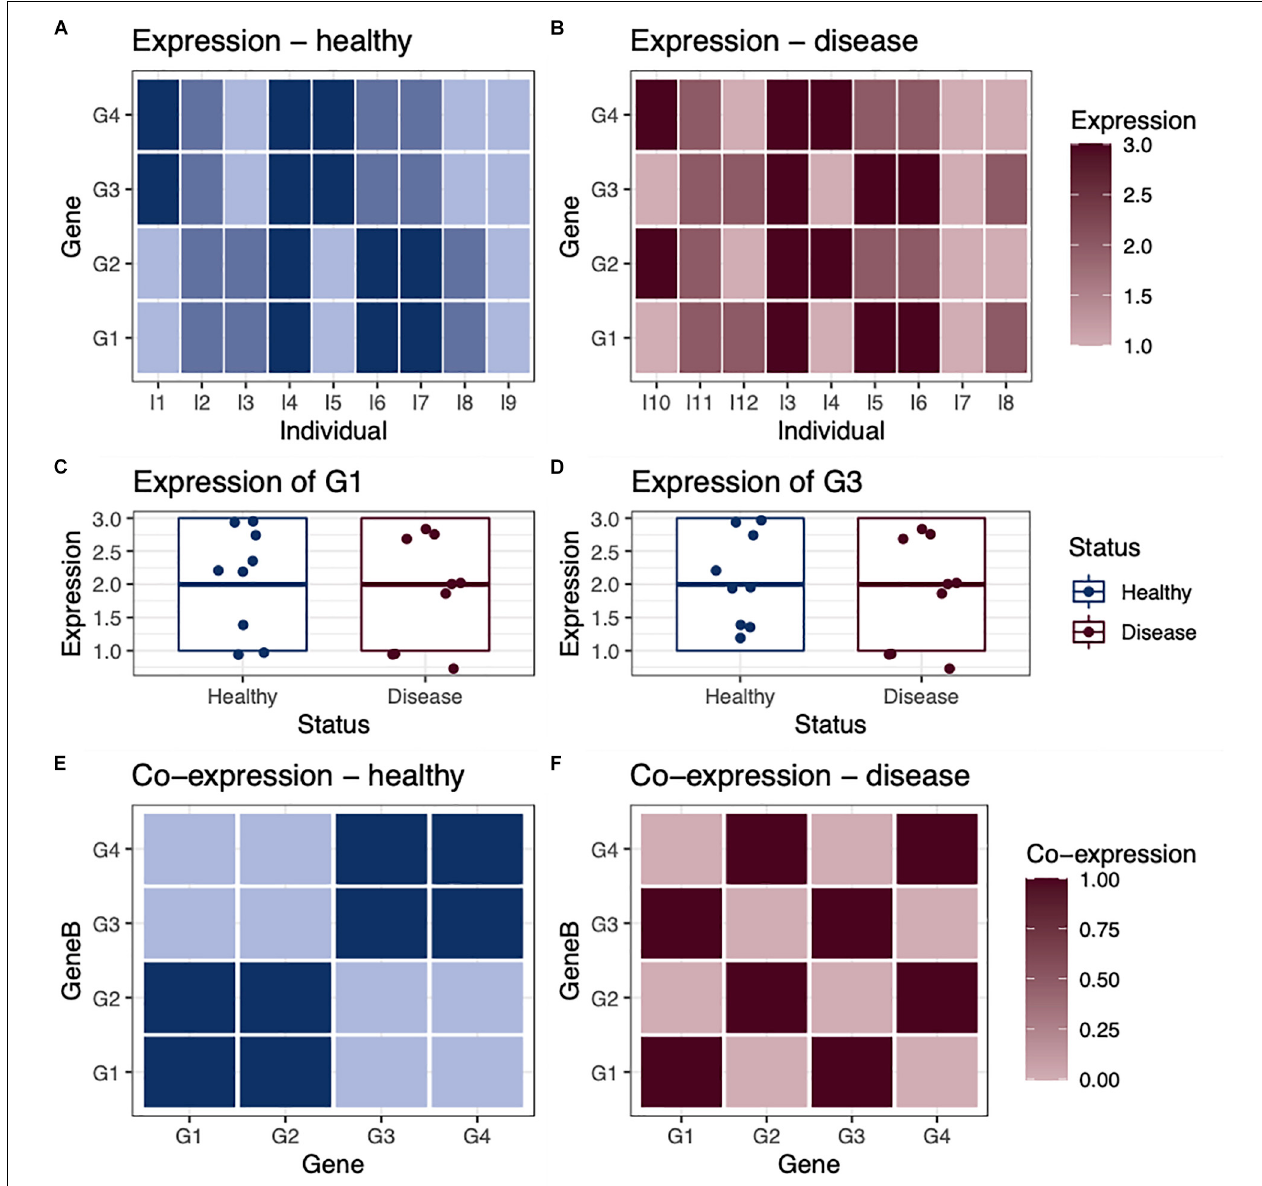
FIGURE 1 | Differential expression vs. differential co-expression. As a toy example, we consider the expression of four genes in (A) nine healthy individuals and (B) nine individuals with a disease. In this example, none of the genes are differentially expressed, as they have a similar average expression level in both healthy and disease individuals, shown in examples (C) gene G1 and (D) gene G3. However, when we look at the co-expression between genes within healthy individuals (E) and within disease individuals (F) , we see that there is obvious differential co-expression between genes in healthy individuals, compared with disease